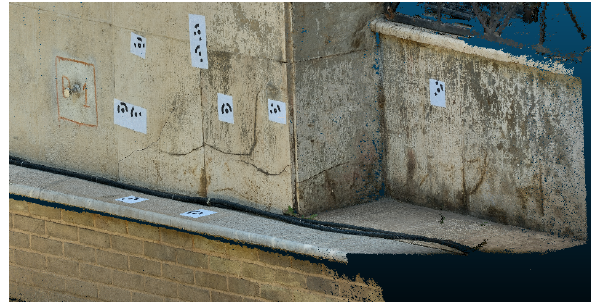
Figure 6. Dense textured point cloud.